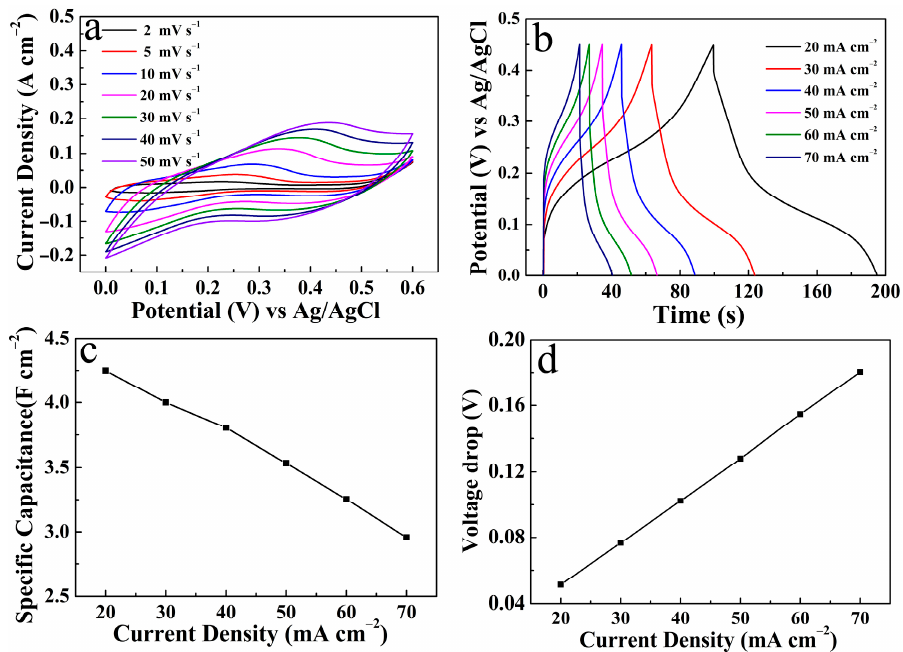
Figure 9. Electrochemical properties of the CuO/NCS electrode (S-300): ( a ) CV curves; ( b ) GCD curves; ( c ) C s; and ( d ) voltage drop at di ff erent current densities.